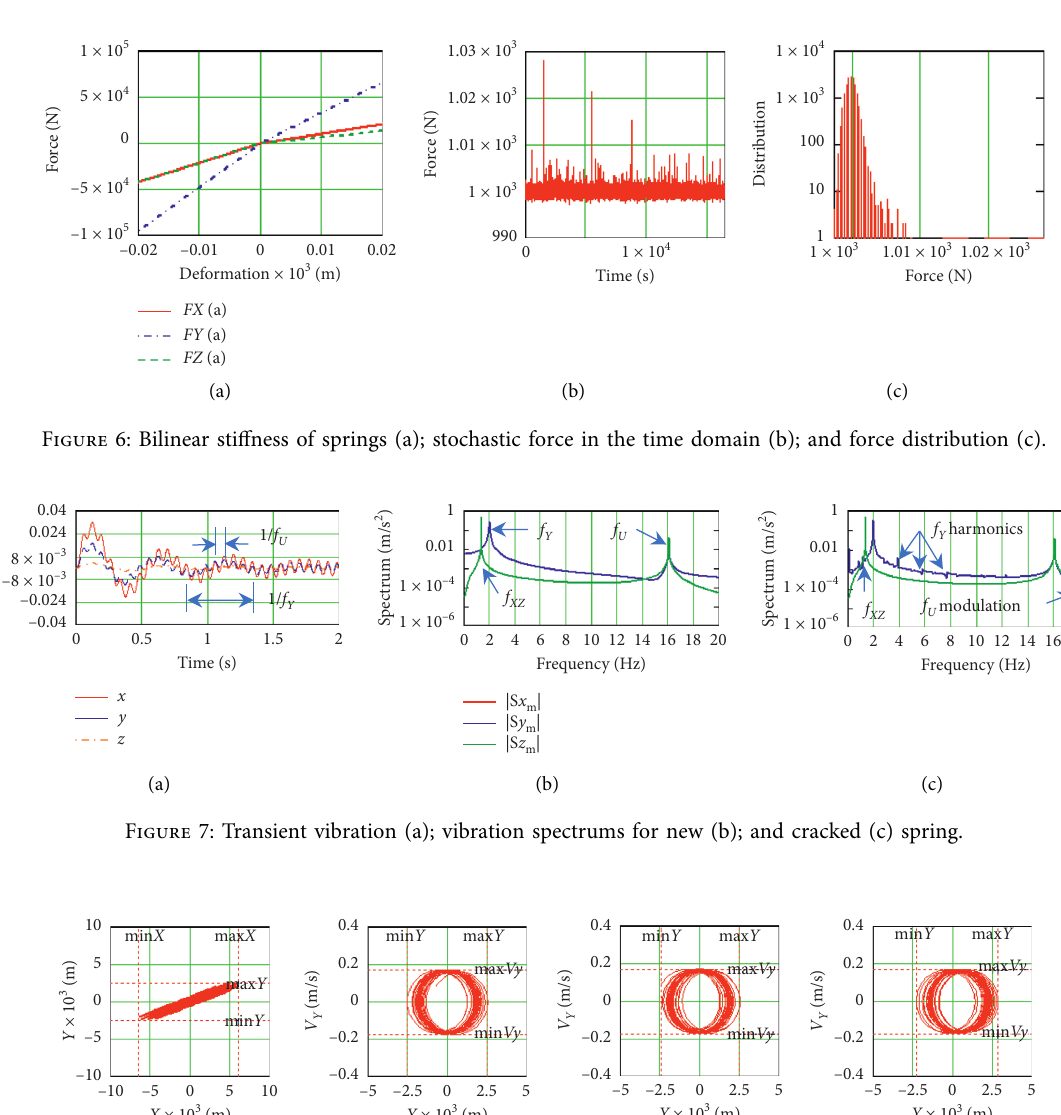
Y ; (d) with a crack in spring